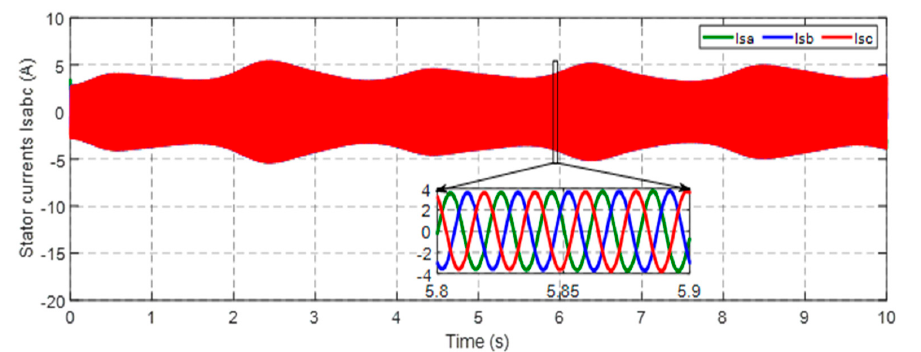
Figure 18. Power Factor.